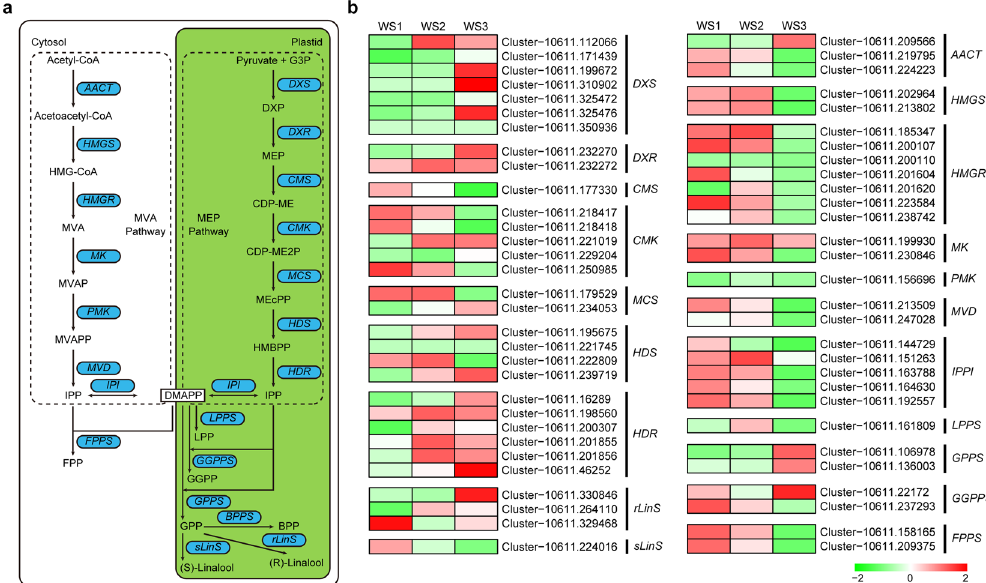
Figure 5. Differential expressions of the unigenes related to the essential oil (EO) biosynthesis pathway in YXA-5. ( a ) Schematic diagram of the terpene biosynthesis pathway. ( b) Heatmap depicting the expression profile of genes related to EO biosynthesis in different reaction